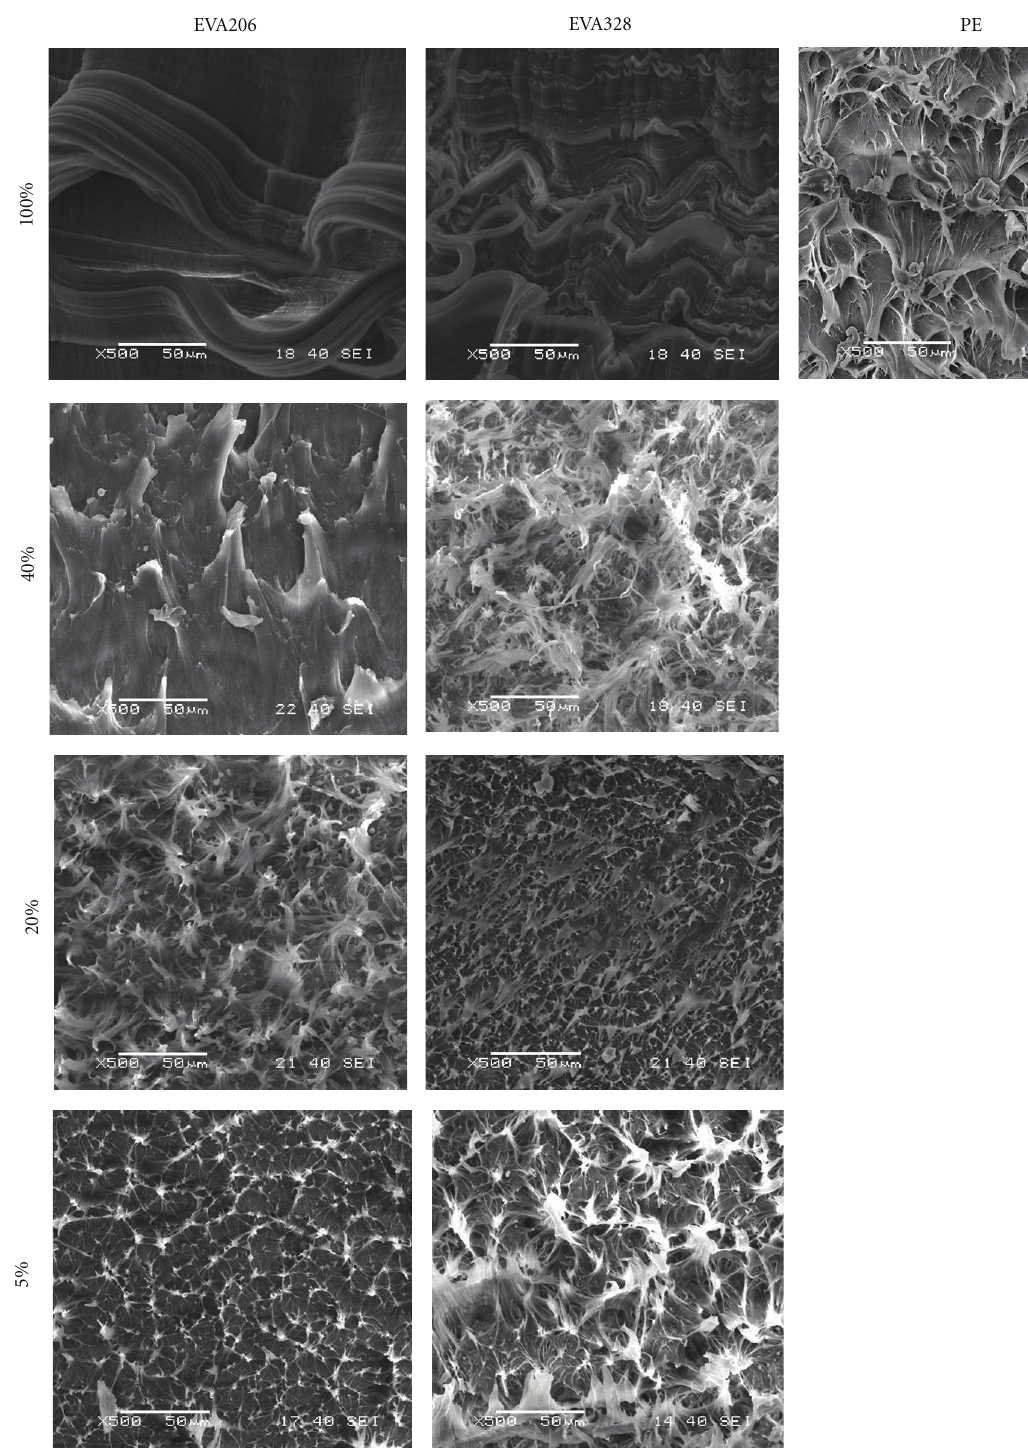
Figure 1: Fracture surface of HDPE/EVA